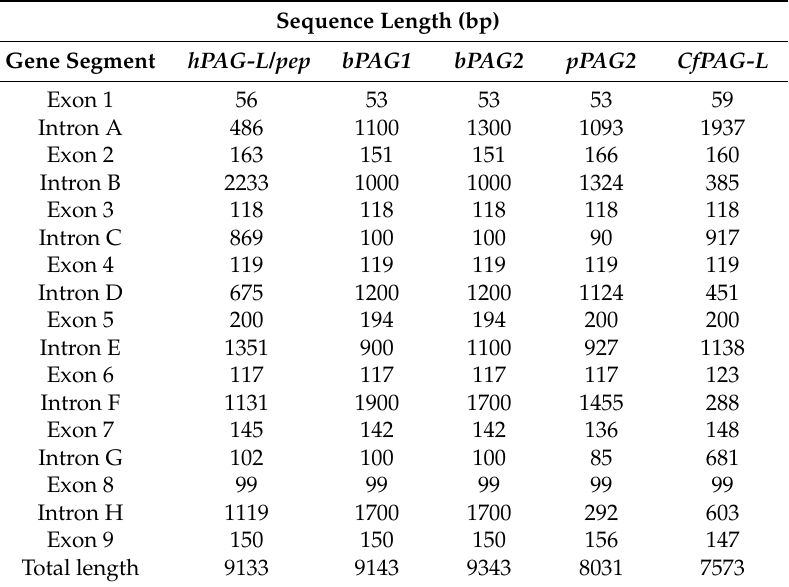
Table 4. Exonic and intronic length of the hPAG-L/pep compared to bPAG1 , bPAG2 , pPAG2 and CfPAG-L genes.